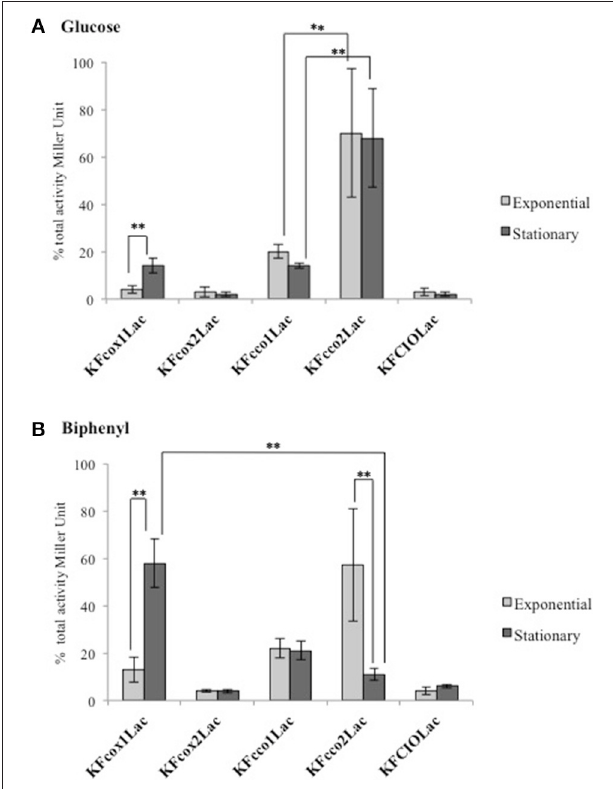
FIGURE 2 | β -Galactosidase activities measured in cell extracts derived from the KF707 translational fusion mutant strains ( Table 1 ), grown aerobically in MSM medium with glucose (A) and biphenyl (B) as sole carbon source. The assays were performed (at least six times) at two different stages of growth (exponential phase OD 600 nm 0.3–0.5 and stationary phase OD 600 nm 0.7–0.9) and the activities are presented as percentage of total activity. Error bars indicate standard deviation of the means. Asterisks indicate that mean values are significantly different according to one-way ANOVA and verified by a two samples T -test within pairs of strains (** p <